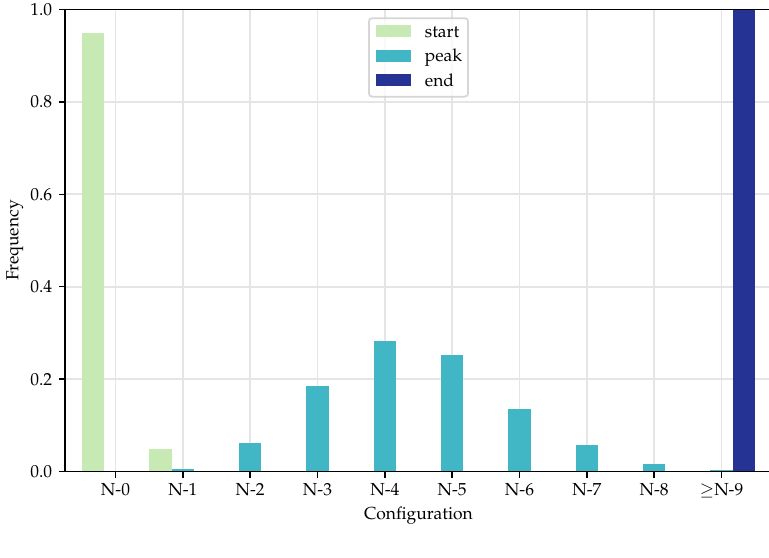
Figure 3. Summary of sampled system configurations. Table 2. Worst-case outage severity coefficient of